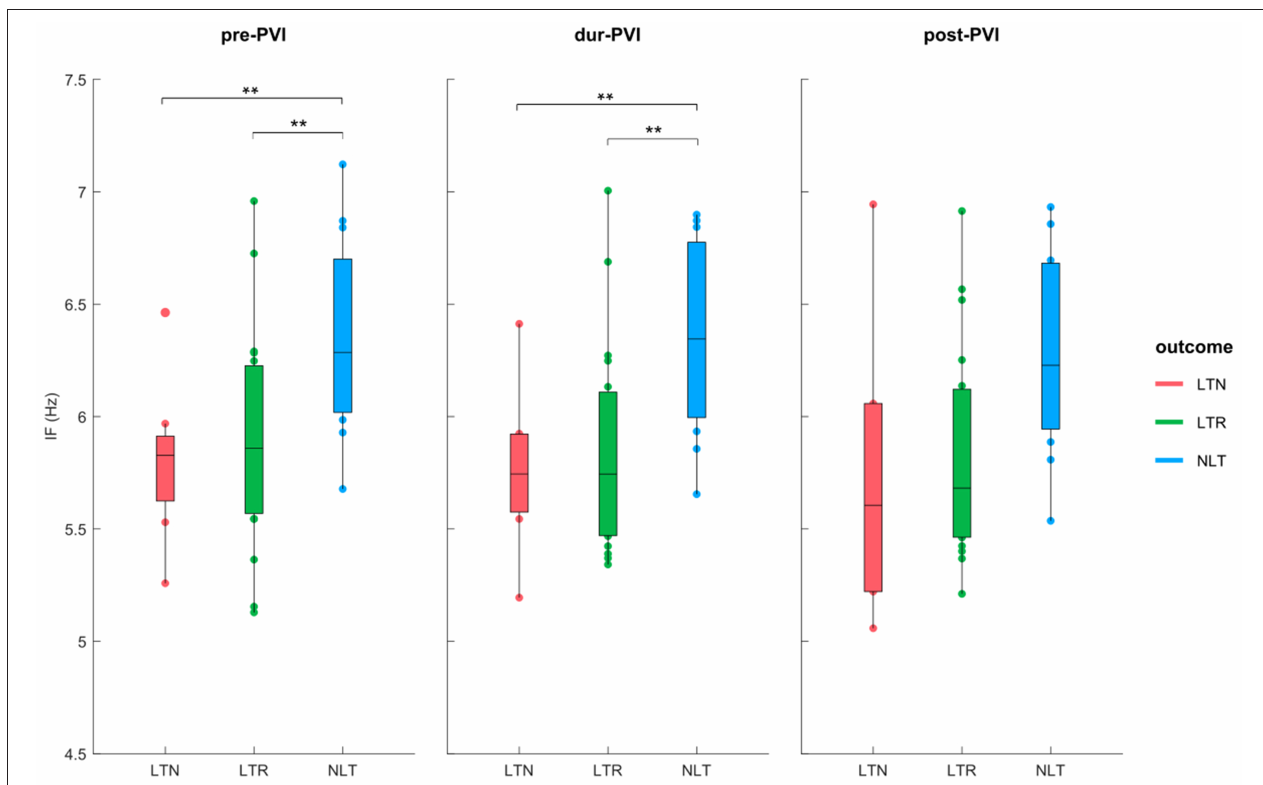
FIGURE 3 | IF at pre-PVI, dur-PVI, and post-PVI for all patient groups. Significant differences between groups at each ablation step are displayed; ** p < 0.01 .